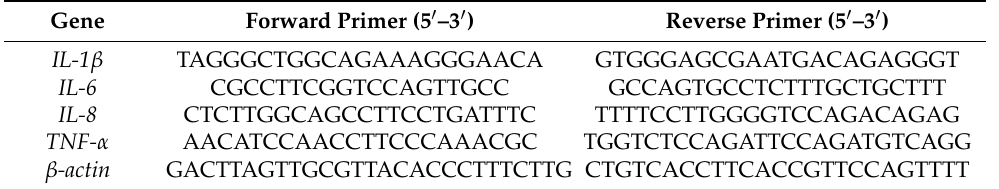
Table 2. Primers used for qRT-PCR.